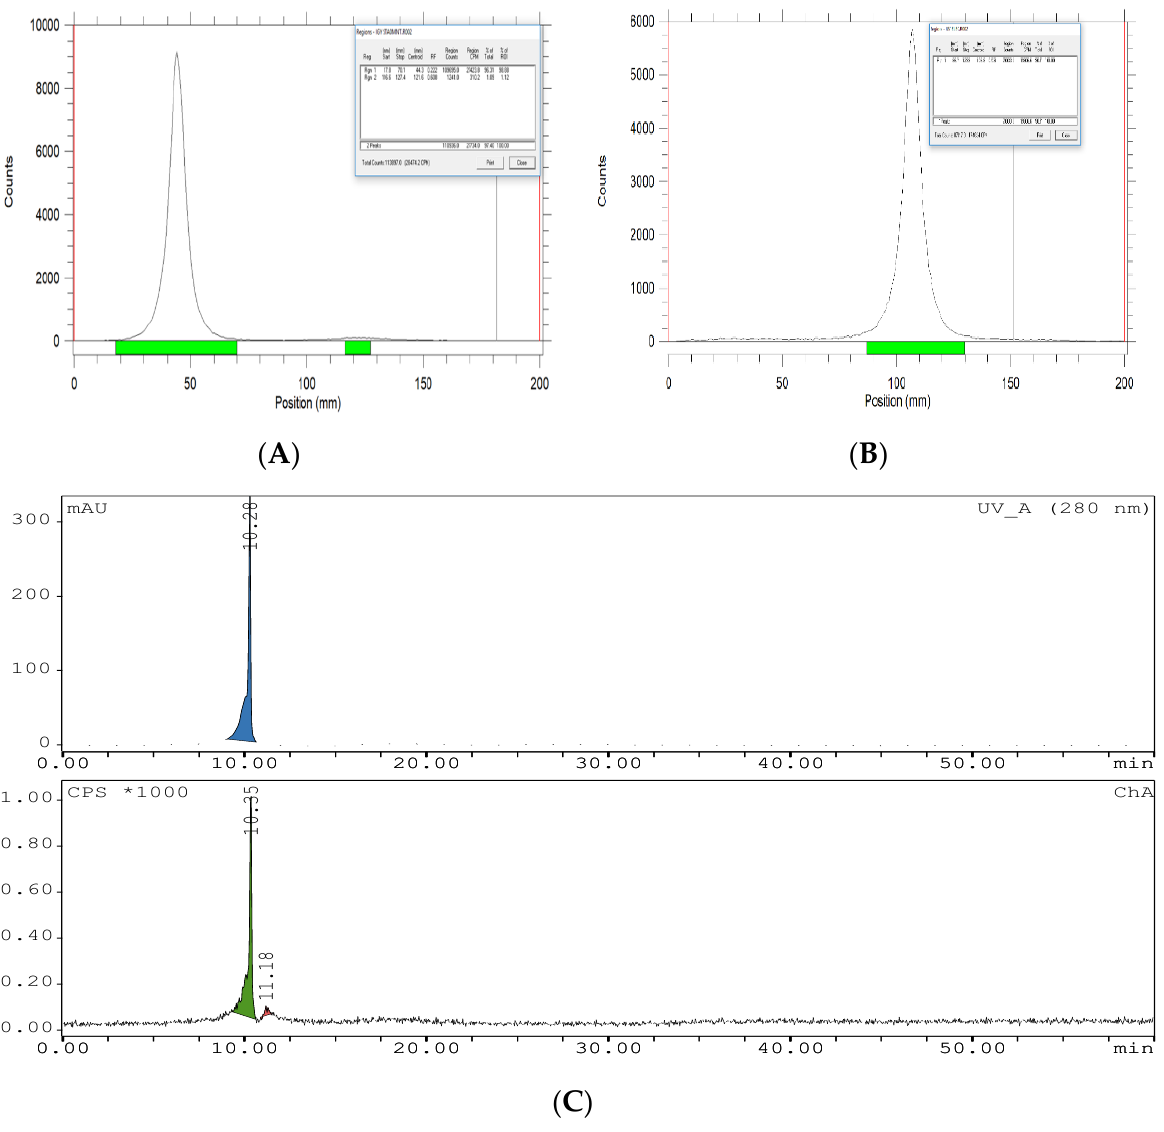
Figure 4. Representative radio-TLC chromatogram of [ 131 I]-IgY anti-RBD spike SARS-CoV-2 ( A ), electropherogram of [ 131 I]IgY anti-RBD spike SARS-CoV-2 ( B ), and HPLC profiles of [ 131 I]-IgY anti-RBD spike SARS-CoV-2: UV detector (above) and radioactive detector (below) ( C ).